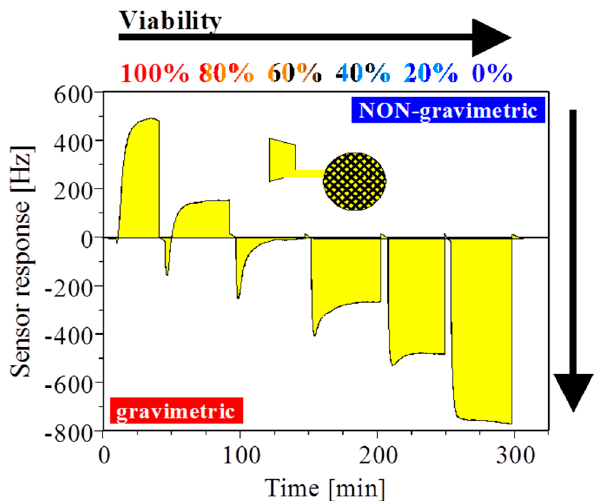
Figure 4. Differential sensor response with a S. cerevisiae imprinted layer on a grid electrode. All samples had a constant cell concentration of 10 7 cells/mL. Gravimetric and non-gravimetric responses are observed depending on the cell viability. The area under the response curve is colored in yellow to guide the eye.